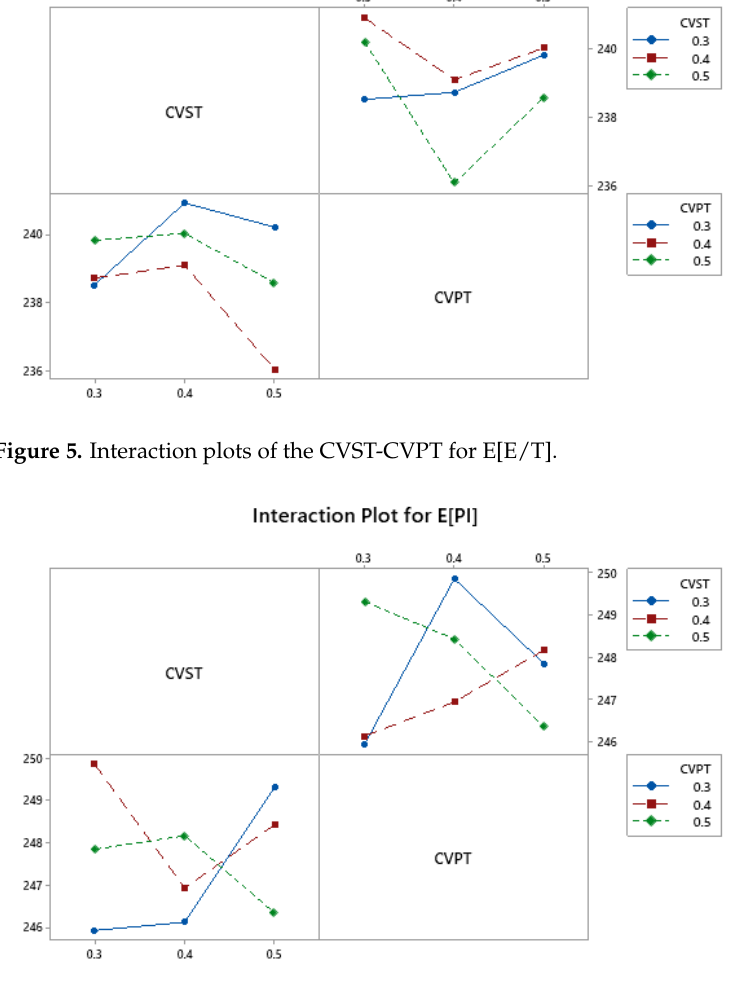
Figure 6. Interaction plots of the CVST-CVPT for